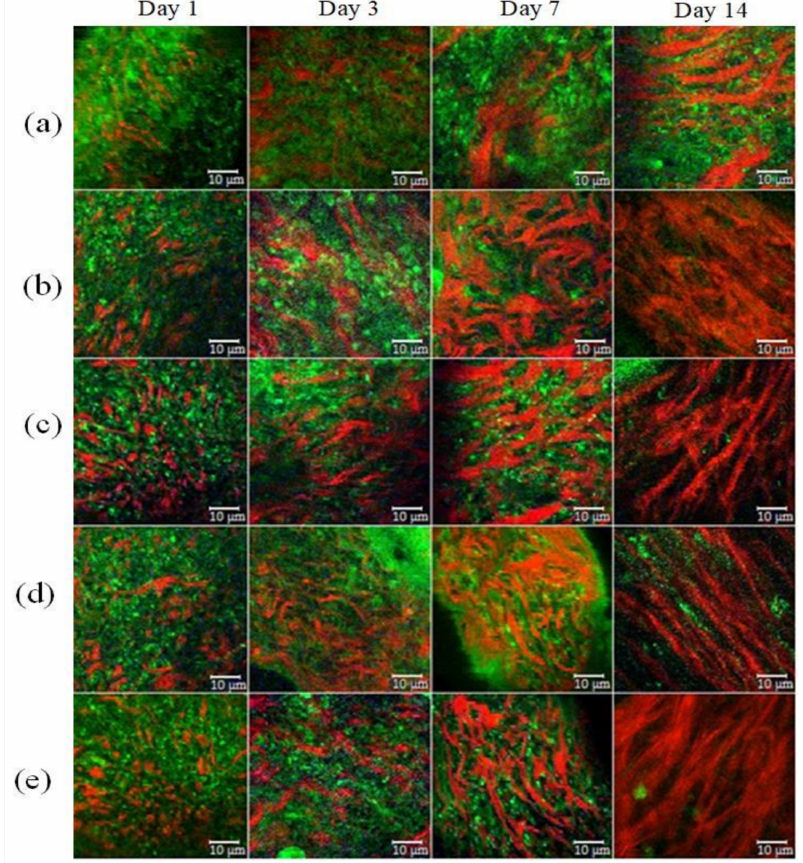
Figure 4. SHG (red) and AF (green) images of wound healing. ( a ) Control group; ( b ) LDPDT–5- ALA/1 J/cm 2 ; ( c ) LDPDT–5-ALA/4 J/cm 2 ; ( d ) LDPDT–MB/1 J/cm 2 ; ( e ) LDPDT–MB/4 J/cm 2